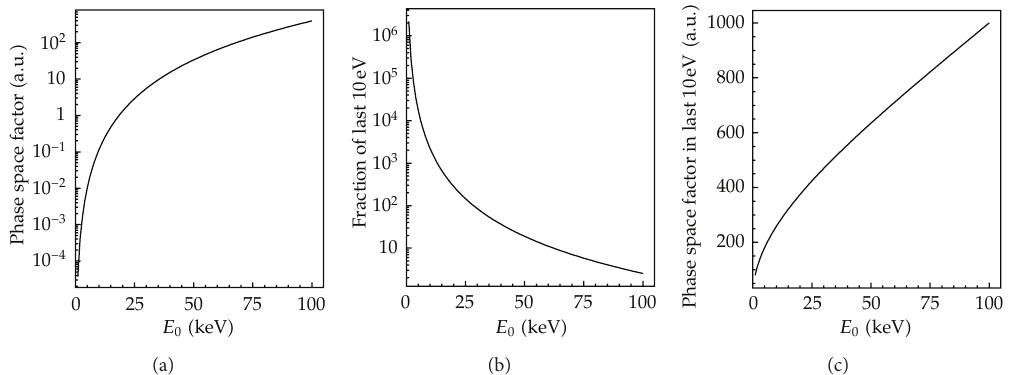
Figure 4: Dependence on endpoint energy 𝐸 0 of total count rate (a), relative fraction in the last 10eV below the endpoint (b), and total count rate in the last 10eV of a 𝛽 -emitter (c). These numbers have been calculated for a superallowed 𝛽 -decay using (18) for 𝑚(𝜈 𝑒 ) = 0 and neglecting possible final states as well as the Fermi function 𝐹 .